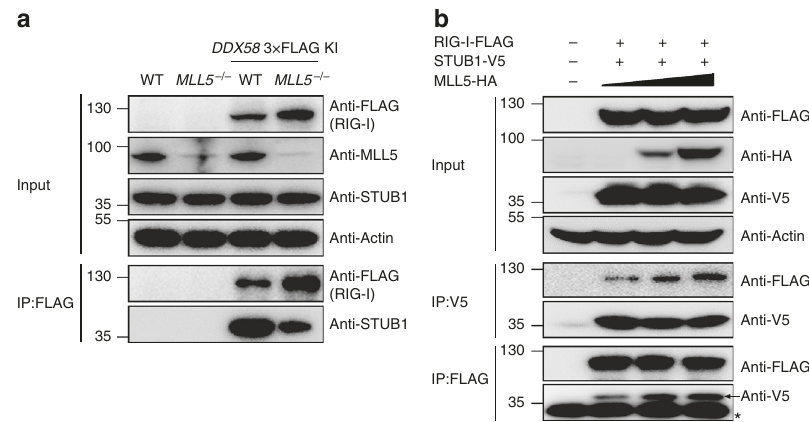
Fig. 6 MLL5 facilitates interaction between RIG-I and STUB1. a Co-immunoprecipitation and immunoblot analysis of STUB1 in the WT and MLL5 − / − HEK293T cells and the DDX58 3×FLAG knock-in WT and MLL5 − / − HEK293T cells. Actin served as a loading control. KI, knock-in. b Co- immunoprecipitation and immunoblot analysis of HEK293T cell cotransfected with RIG-I-FLAG and STUB1-V5 with MLL5-HA plasmids (0, 1000, and 3000 ng). Arrow indicates STUB1 band. *IgG light chain. Data are representative of three independent experiments with